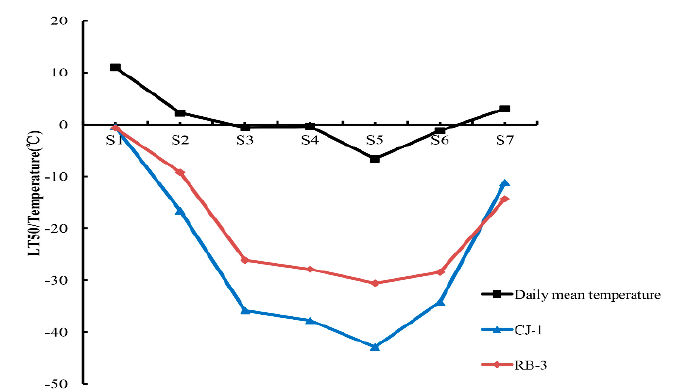
Figure 1. Seasonal changes in air temperatures data at the sampling site (111°27 ′ E, 33°81 ′ N) from October 2017 to March 2018 and freezing tolerance estimated as the half lethal temperature (LT50) in the shoots of “CJ-1” and “RB-3” kiwifruit cultivars. Table 1. Sampling time corresponding to phase.